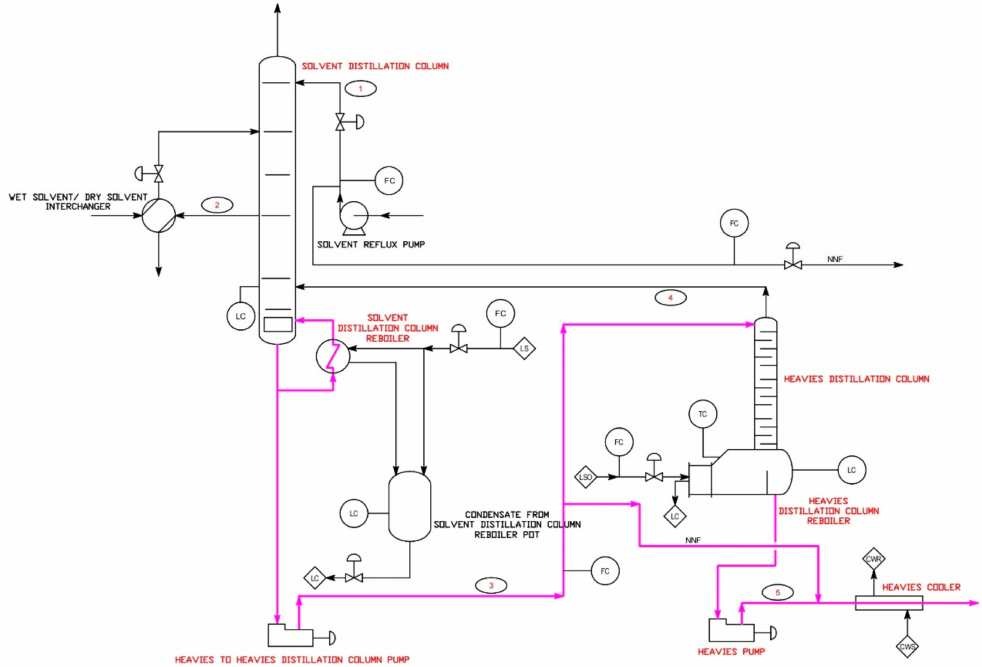
Figure 5. SSBR plant markup in PFD